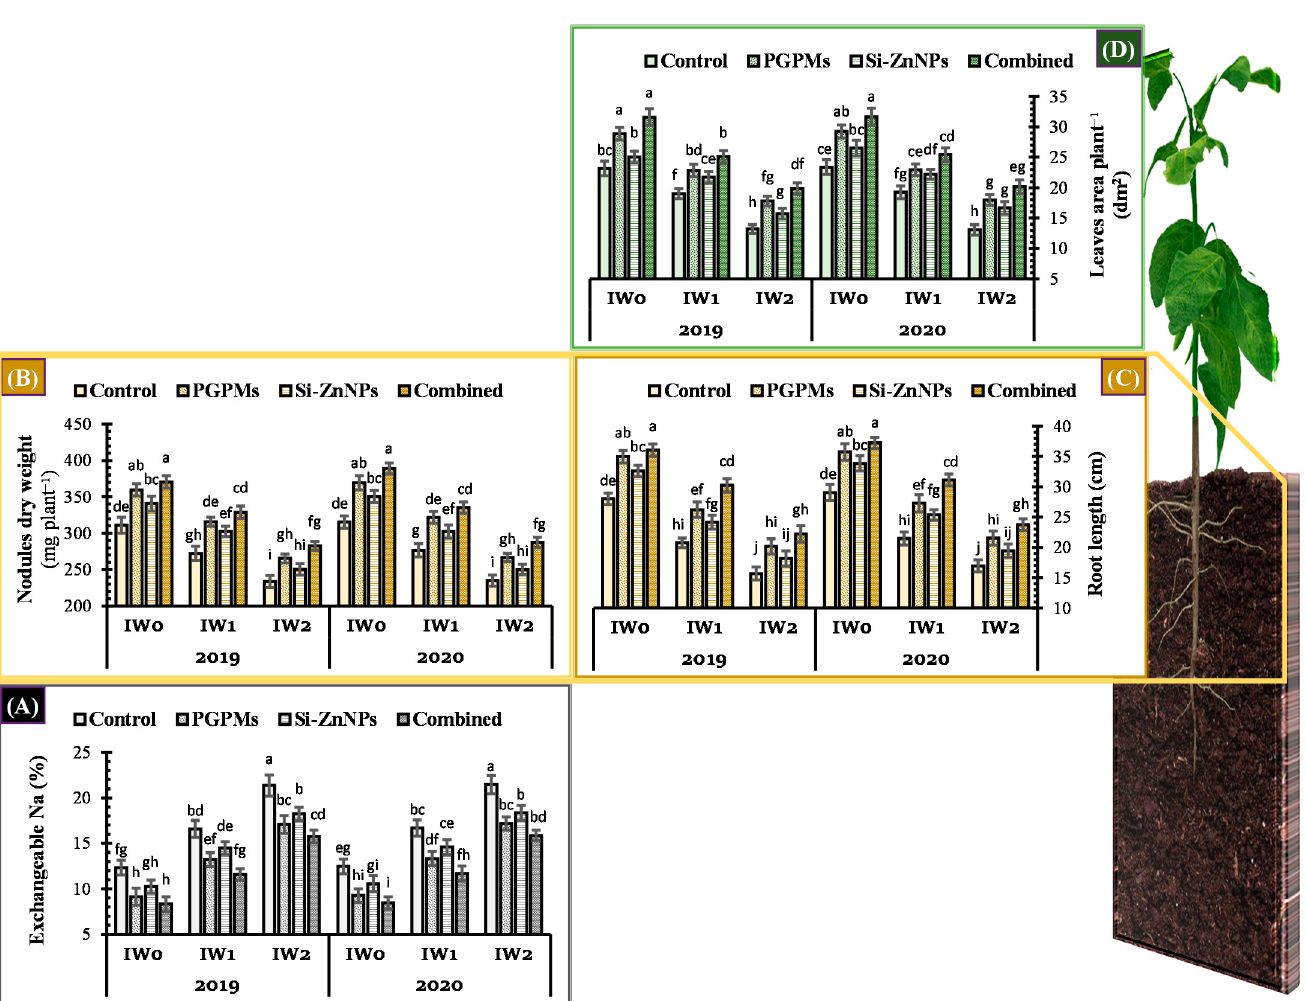
Figure 1. Influence of application of PGPMs, Si-ZnNPs and their combination on ( A ) the percentage of exchangeable Na in the soil, and ( B ) nodules dry weight, ( C ) root length, and ( D ) total leaves area of soybean plant grown in salt-affected soil with different levels of watering intervals ( IW 0 ; 11 days, IW 1 ; 15 days, and IW 2 ; 19 days) during the successive 2019 and 2020 growing seasons. The data presented as means ± SD. Means labeled with the same lower-case letter are not significantly different according to Duncan’s Multiple Range Test.